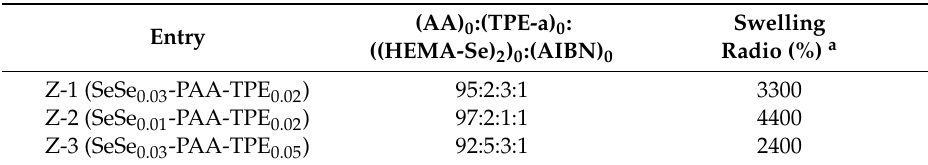
Table 1. Preparations of SeSe y -poly(acrylic acid)(PAA)-tetraphenylethylene (TPE x ) with different feed ratios in dimethylformamide (DMF) at 70 ° C.